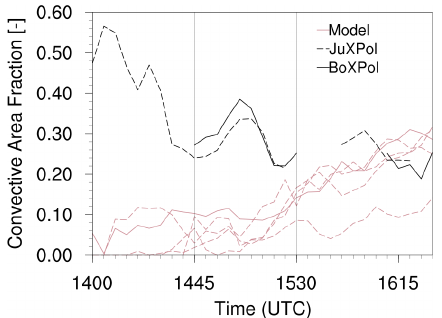
Figure 7. Convective area fraction (CAF) of model ensemble mem- bers and observations. The two vertical bars define the time period used to compute contoured frequency altitude diagrams (CFADs) for the observation and model. The ensemble member, with a solid line, is used for polarimetric signature comparison. The CAF esti- mates from BoXPol or JuXPol are shown upon coverage and data availability. The gaps in the radar data represent times when the po- larimetric signatures are strongly attenuated or if the storm extent is only partially covered by the